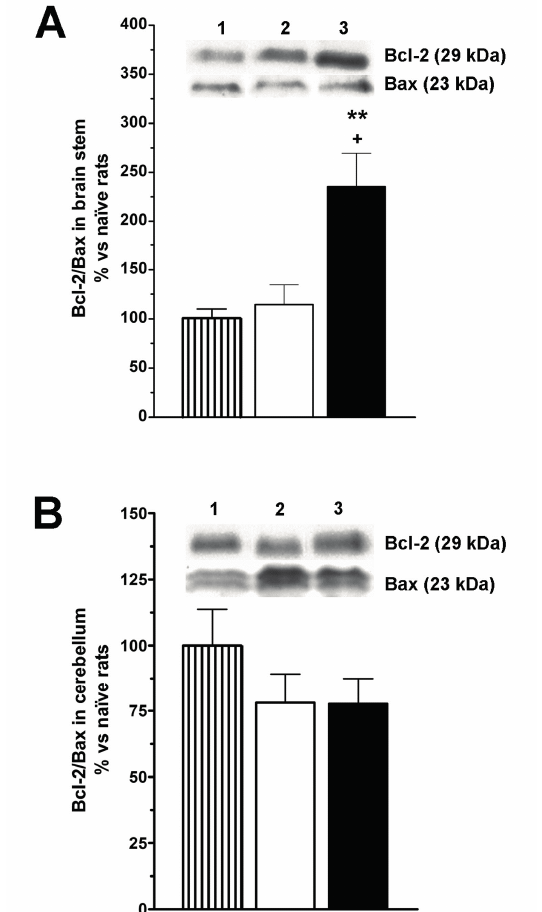
Figure 4. Liver growth factor up-regulates Bcl-2 and protein levels in the brainstem of 3-acetylpyridine ataxic rats. Intraperitoneal administration of LGF raises the ratio Bcl2/Bax in the brainstem of 3-AP-lesioned rats ( A , black bars) in comparison with naïve ( A , lined bars) and 3-AP + vehicle treated rats ( A , white bars). Note how this effect is due to an increase in the expression of the anti-apoptotic protein Bcl-2 ( A , lane 3), and how LGF treatment does not modulate Bcl2/Bax ratio in the cerebellum ( B ). Lane 1: naïve rats (control); lane 2: 3-AP + vehicle; lane 3: 3-AP + LGF. Results represent the mean ± SEM of 4 to 11 individual animals. ** p ≤ 0.01 vs. naïve rats, + p ≤ 0.05 vs. 3-AP + vehicle